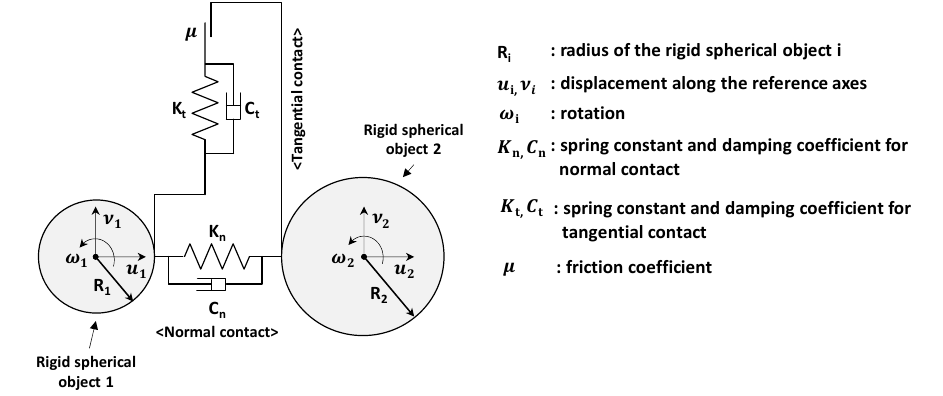
Figure 4. Applied contact model for considering contact between the rigid particles.